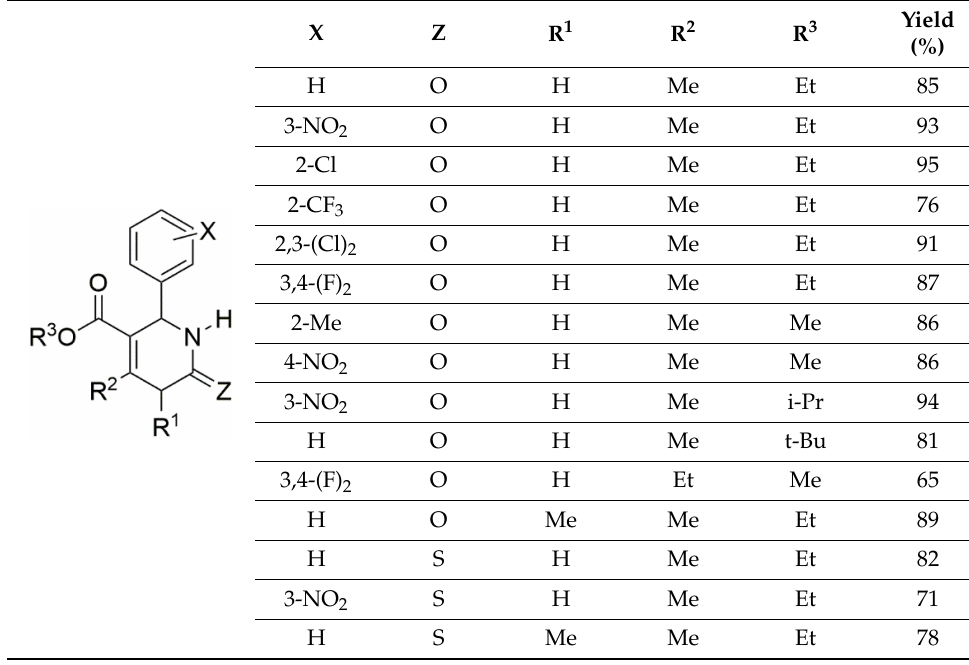
Table 4. PPE as the mediator of the reaction and coupling with microwave irradiation in order to synthesize various substituted